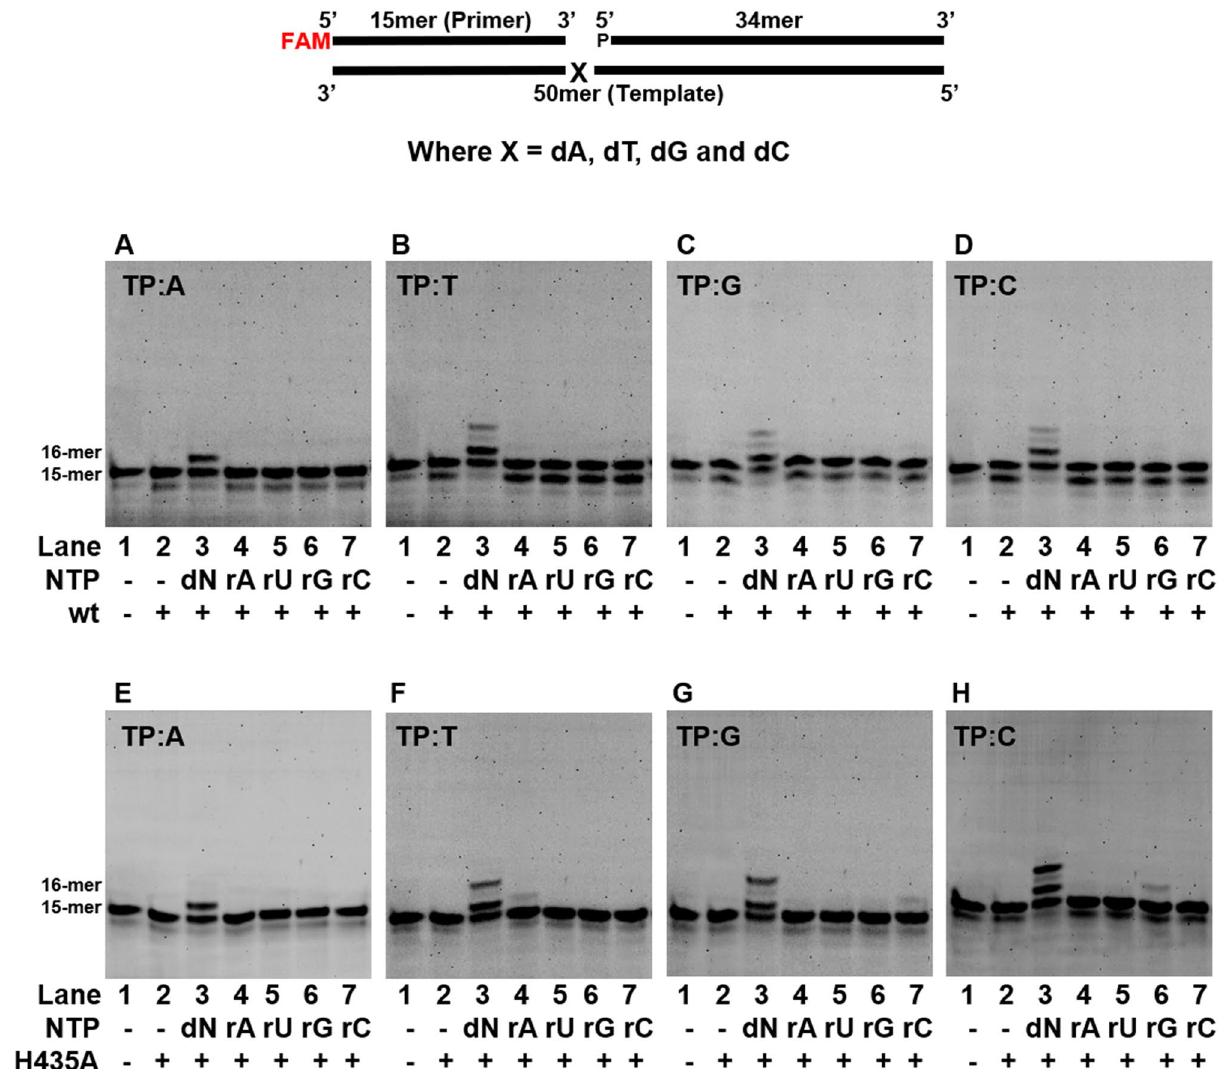
Figure 7. Comparison of rNTP incorporation by wt-saPolX and H435A. Primer extension assays were conducted to assess the ability of saPolX to incorporate rATP, rUTP, rGTP and rCTP opposite the four possible template nucleotides- dA, dT, dG and dC. The identity of the template nucleotide is mentioned at the top of each gel picture. wt-saPolX does not incorporate any rNTP as shown in panels ( A – D ), respectively. saPolX-H435A shows incorporation of ( F ) rATP opposite dT, ( G ) rCTP opposite dG and ( H ) rGTP opposite dC ( E ) except incorporation opposite